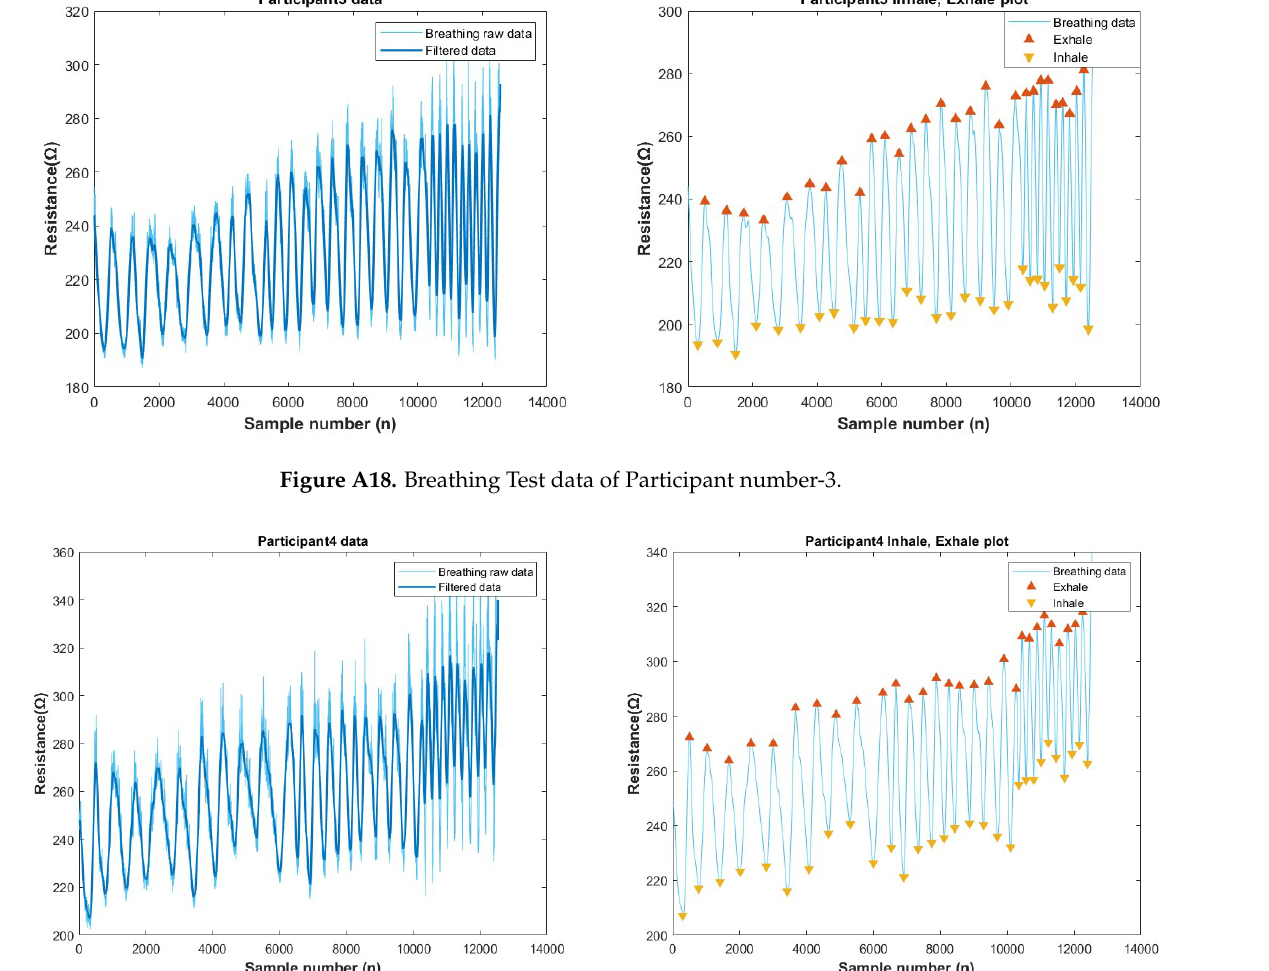
Figure A19. Breathing Test data of Participant